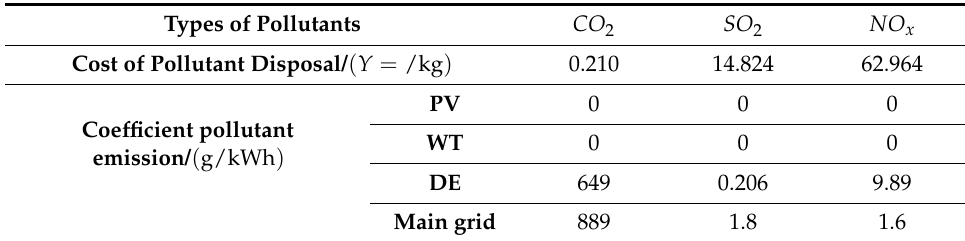
Table A2. Pollutant emission coefficient and disposal